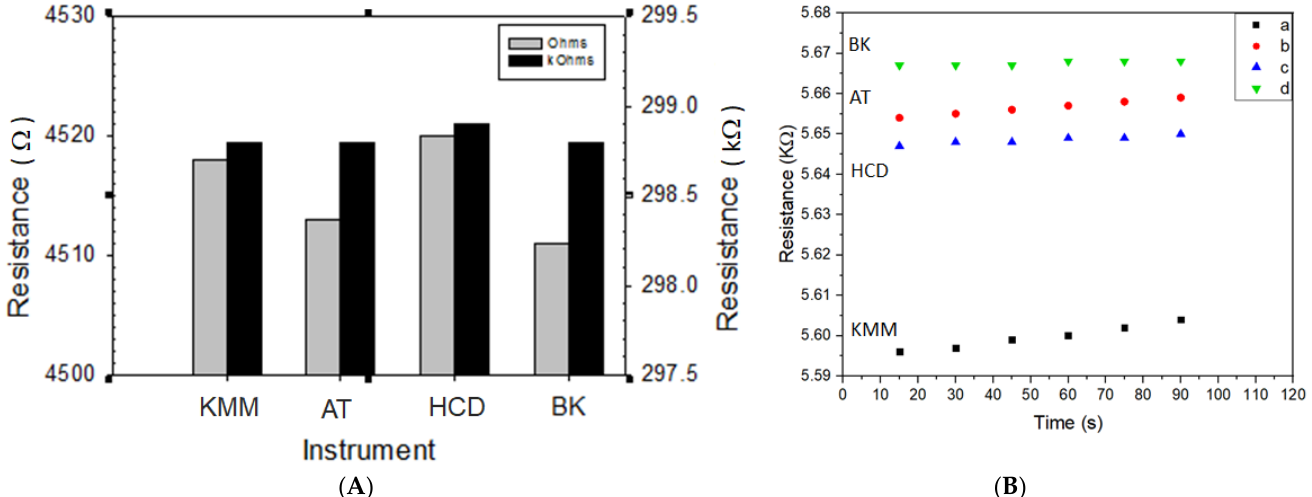
Figure 3. Comparisons of the different instruments in measuring resistance of physical resistors and sensors. ( A ) Comparison of resistance of resistors obtained from four instruments; ( B ) Comparison of resistance of a sensor obtained from four instruments ((a) KMM; (b) AT (Agilent U1252A multimeter); (c) HCD; and (d) BK (B&K Precision 393 Multimeter)).